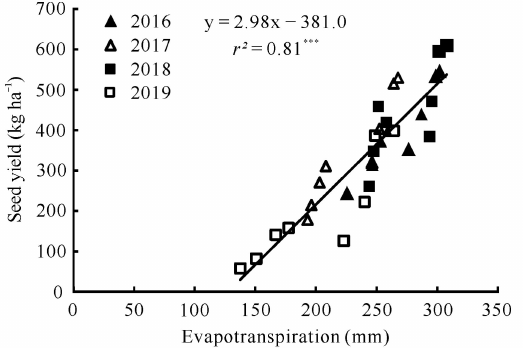
Figure 3. Relationship between evapotranspiration and seed yield of Cleistogenes songorica over four-year period. (Note: *** Indicates significance at p < 0.001